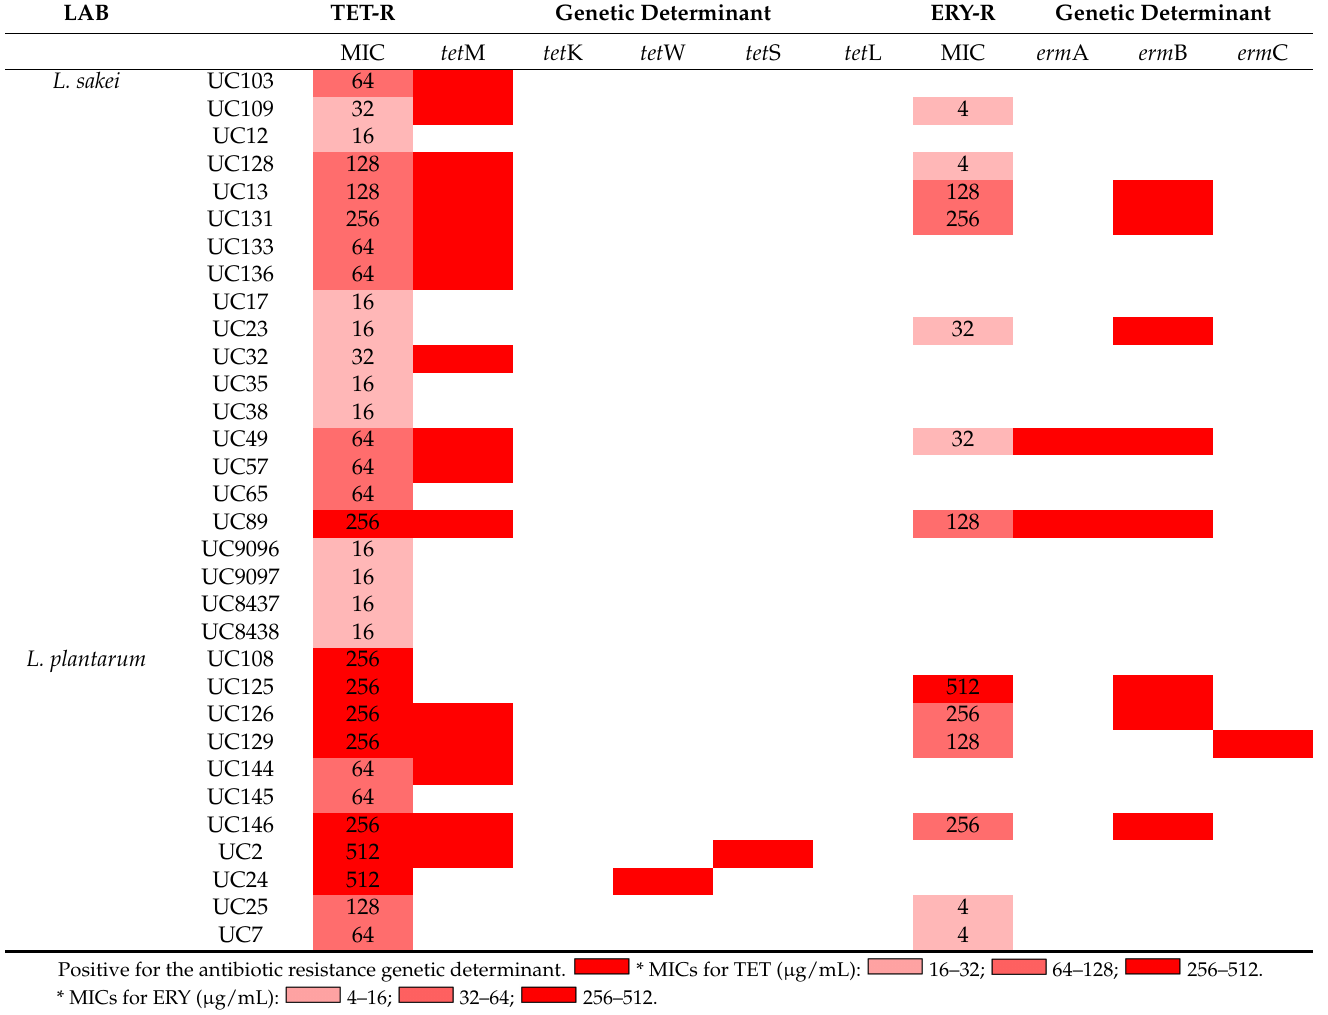
Table 3. Tetracycline (TET-R) and erythromycin (ERY-R)-resistant LAB species: Latilactobacillus ( L. ) sakei and Lactiplantibacillus ( L. ) plantarum . MIC values measured by broth microdilution method using LSM ( µ g/mL) and the distribution of genetic determinants investigated in this study.